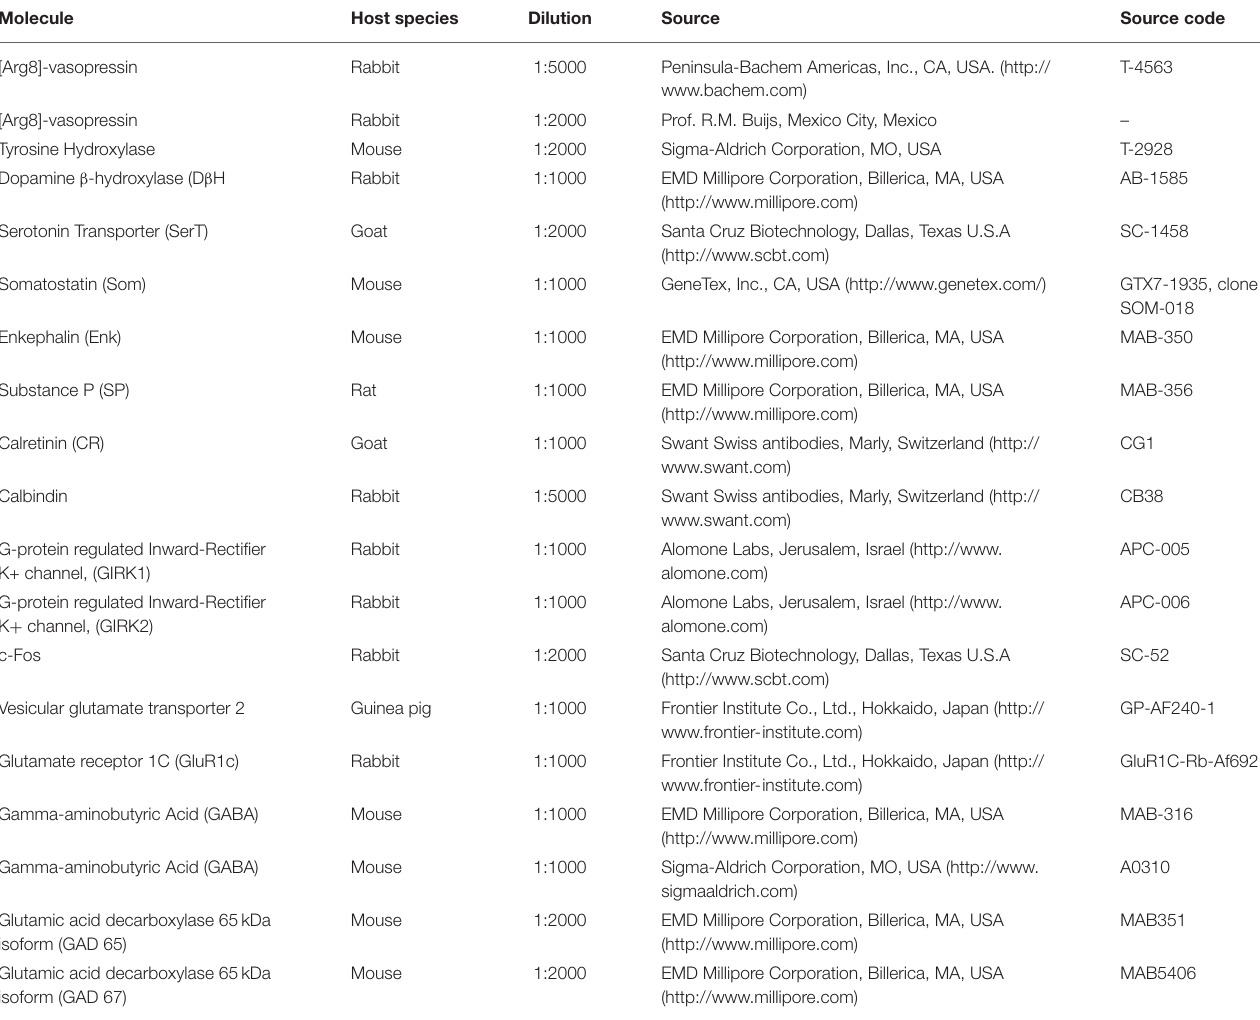
TABLE 1 | Antibody information, related to Materials and Methods.